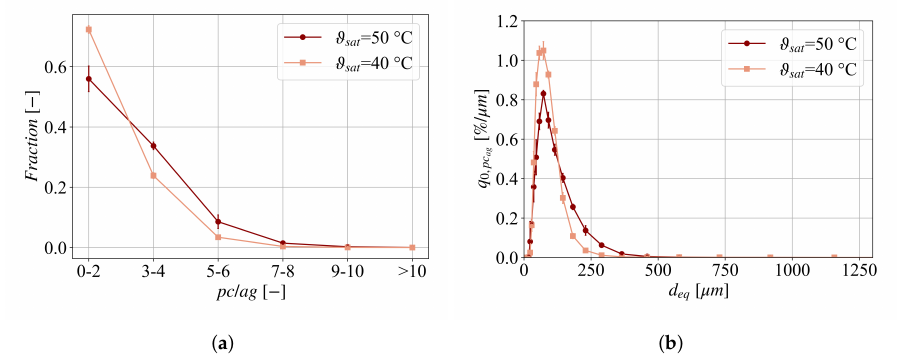
Figure 11. Number based and particle size distribution of primary crystals in agglomerates for ϑ sat = 40 ◦ C in bright and ϑ sat = 50 ◦ C in dark red. ( a ) Number distribution of primary crystals per agglomerate, ( b ) Particle size distribution of primary crystals in